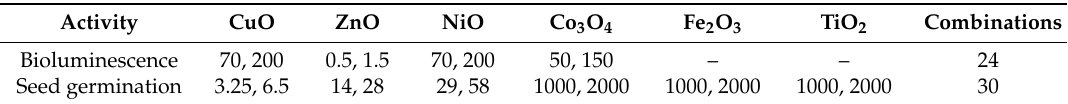
Figure 1. Representative results of bioluminescence activity under three individual NP treatments and two NPs mixtures. “200 CuO + 0.5 ZnO” represents a mixture of 200 mg/L CuO and 0.5 mg/L ZnO. Table 1. Two concentrations of each nanoparticle (mg/L) used in various combinations to create binary NPs mixtures for the bioassays